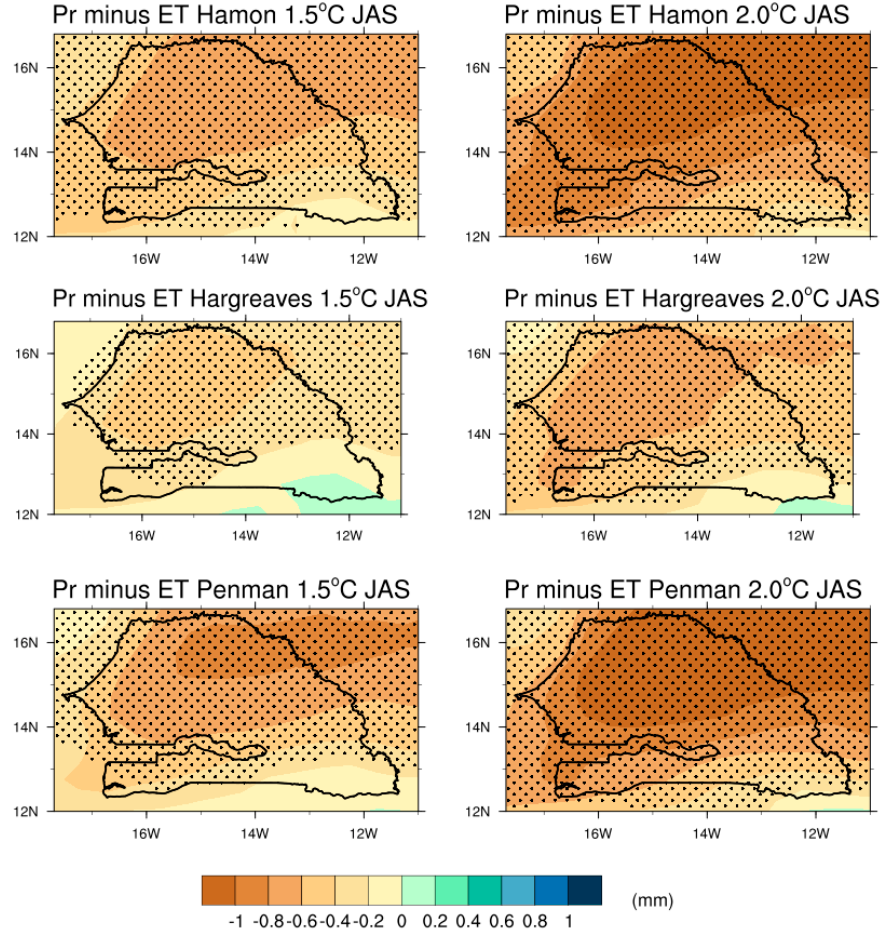
Figure 5. Seasonal water balance (Pr minus ET, first row: Hamon, second row: Hargreaves, third row: Penman) changes under 1.5 °C ( left column ) and 2.0 °C ( right column ) GWLs. Statistically significant changes (Student’s t -test) at 95% confidence level are represented by black dots.